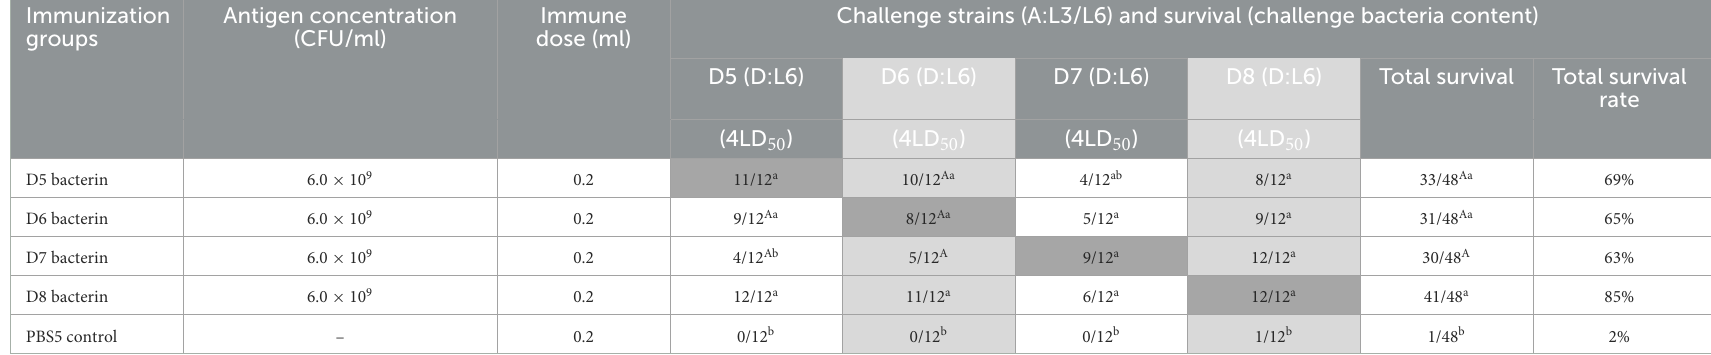
TABLE 6 Protection rate of D5–D8 bacterins against P. multocida strains (Test-5). Immunization groups